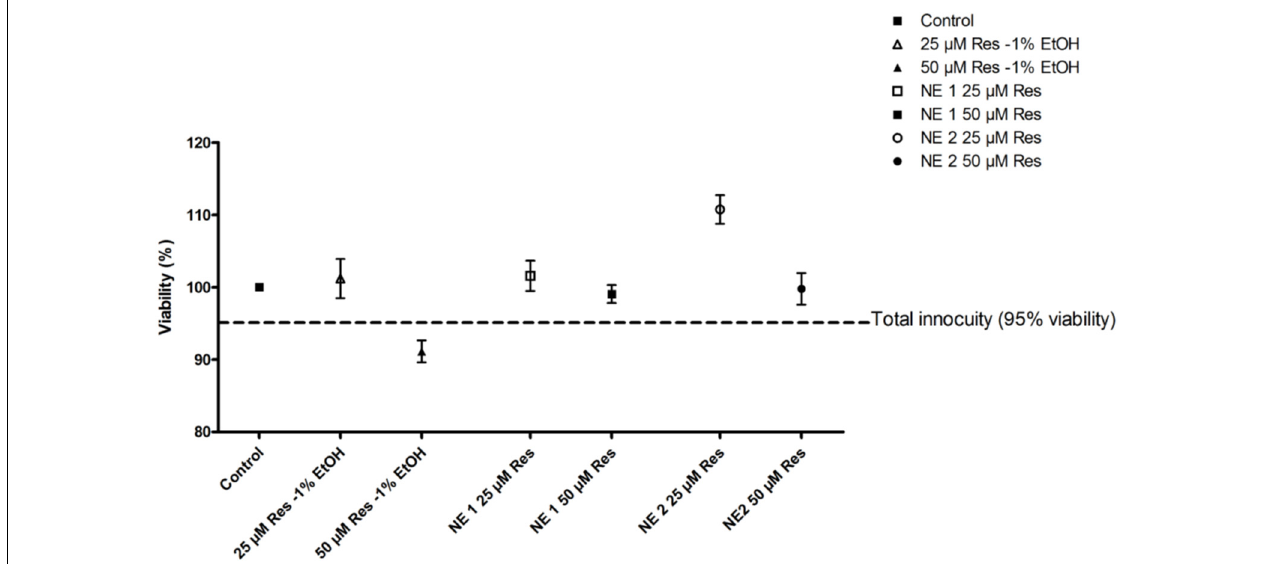
FIGURE 1 | Viability of cells incubated with the resveratrol nano-emulsions or resveratrol in ethanolic solution vs. unexposed control cells. Results are expressed as mean viability percentage ± SEM ( n =